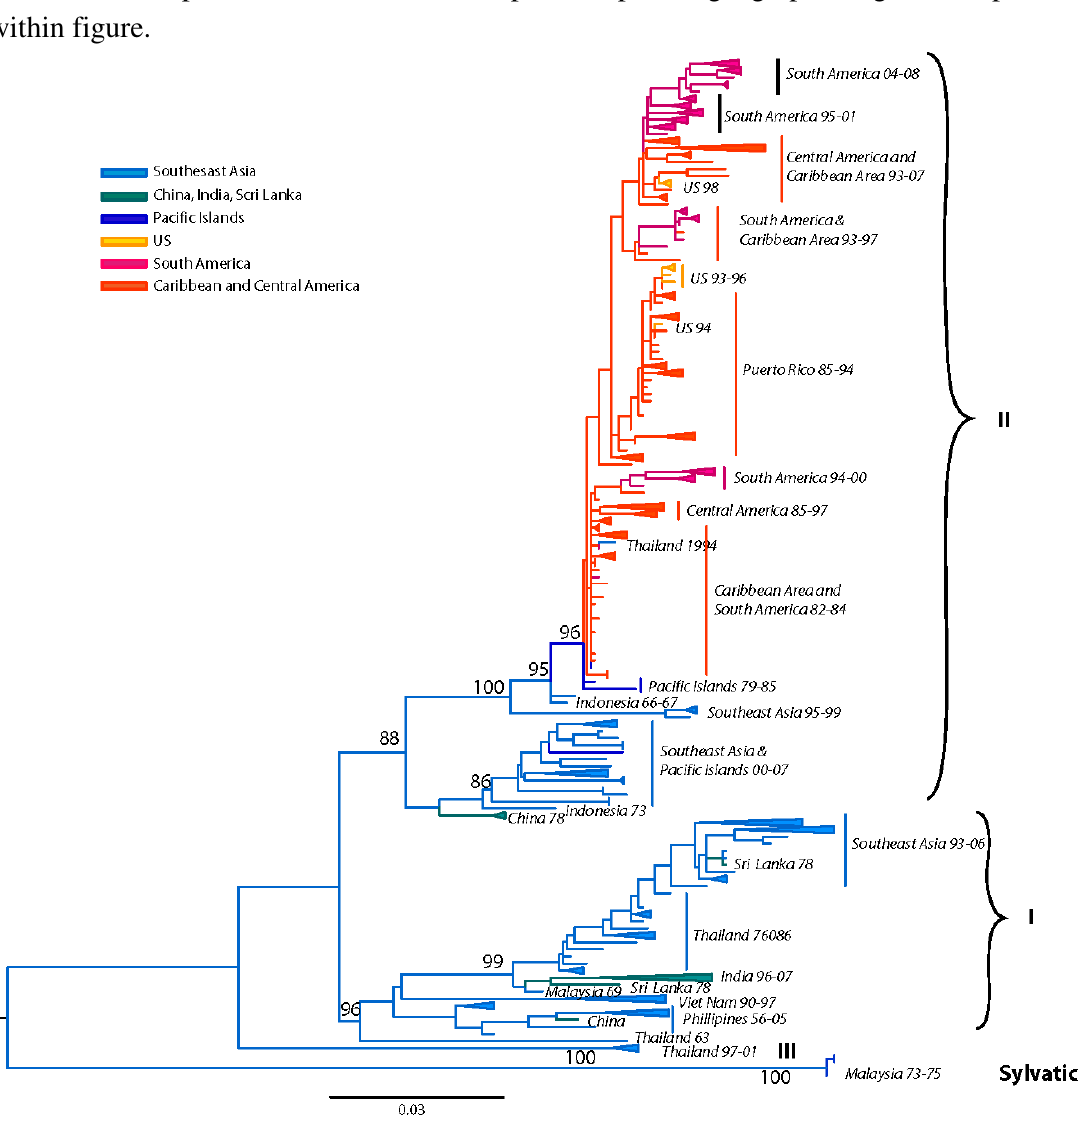
Figure 5. Dengue Virus Type 4 Phylogeny. Maximum Likelihood Tree (MLT) of